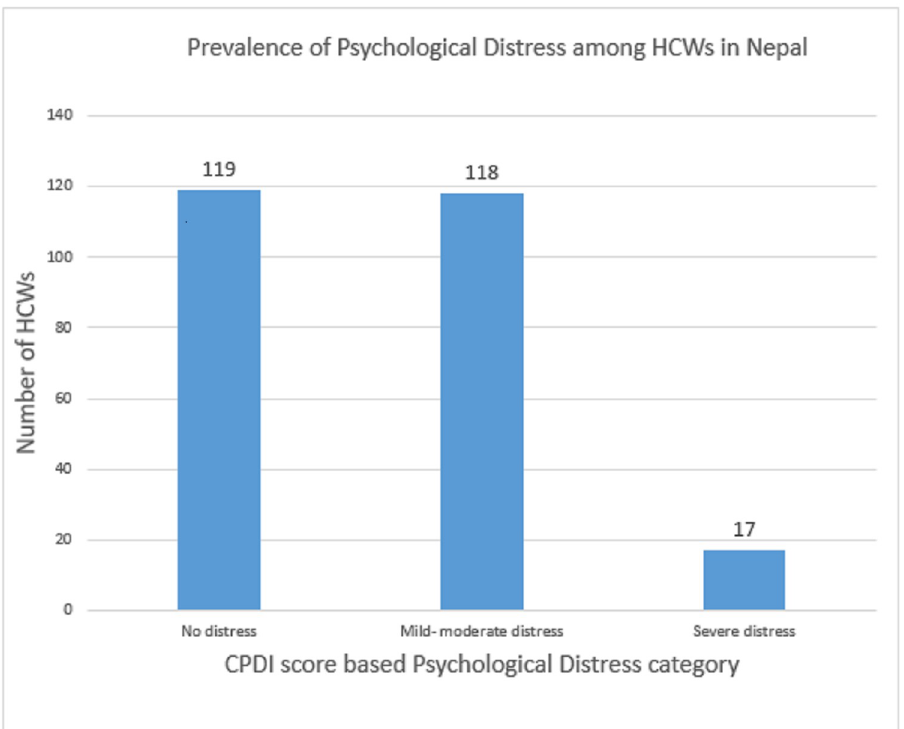
Fig 1. Prevalence of psychological distress among HCWs in